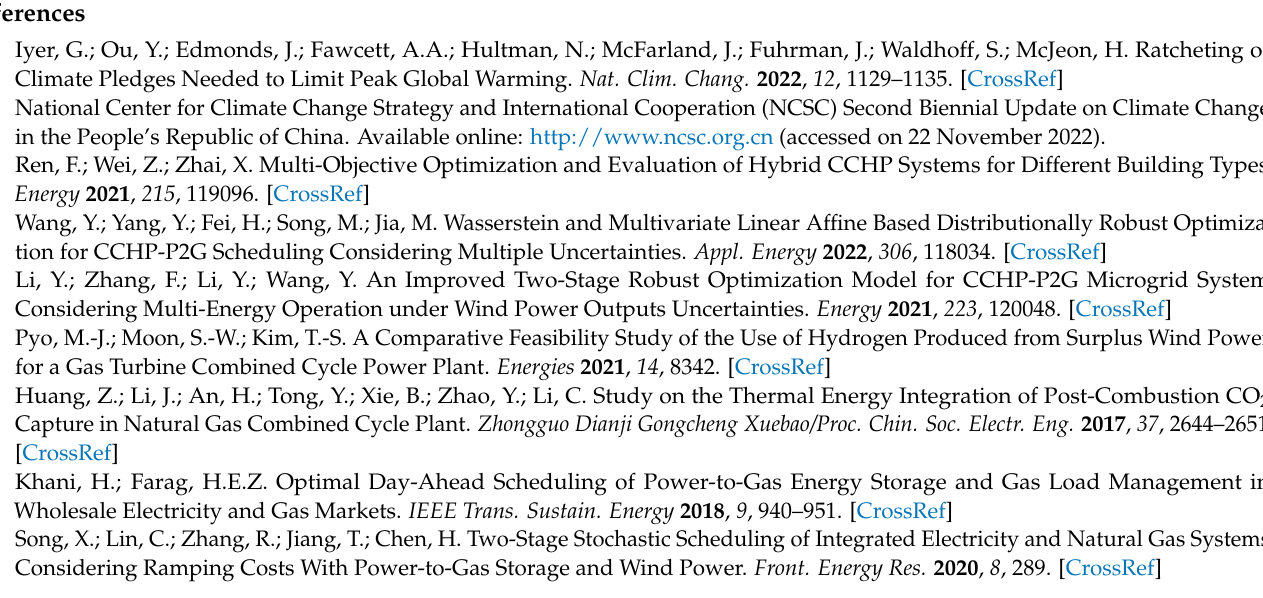
Figure A1. The evaluation matrix of five experts.